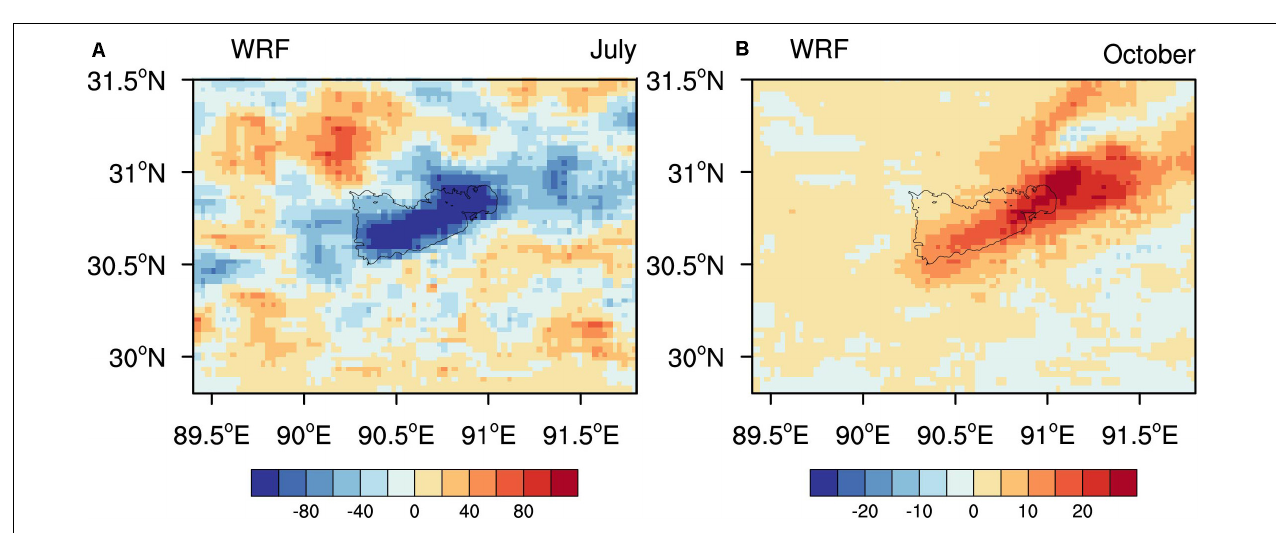
FIGURE 12 | Precipitation difference (mm) between the WRF_lake and the WRF_nolake simulations in July (A) and October (B) of 2008.